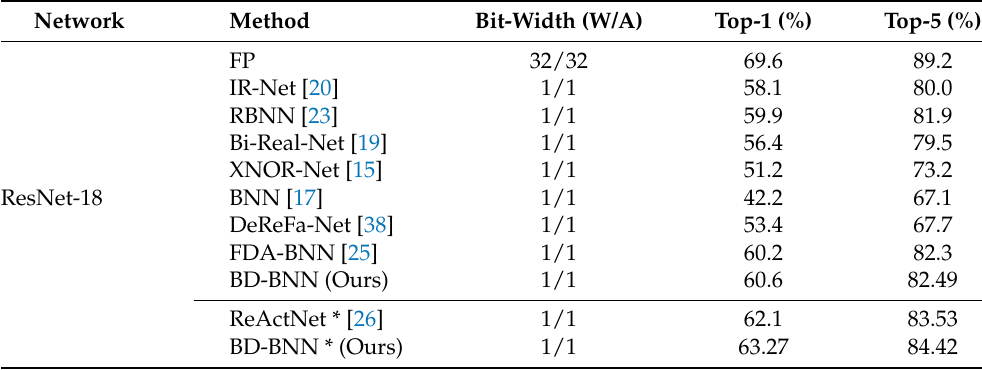
Table 2. Performance comparison with state-of-the-art methods on ImageNet. W/A denotes the bit length of weights and activations. We report the top-1 and top-5 performances in terms of accuracy. ’*’ indicates that ReAct-Net partial structure was used.